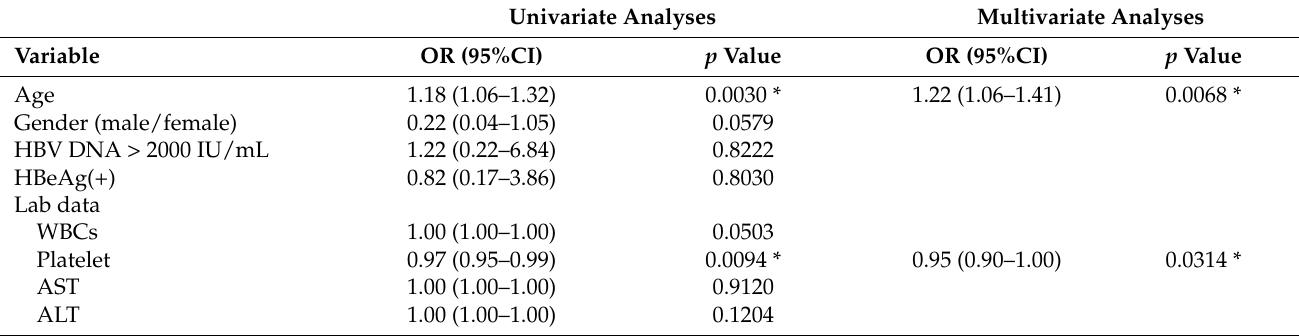
Table 4. Baseline vs. 12M FIB-4 index analysis in LAM ( n = 53). Univariate Analyses Multivariate